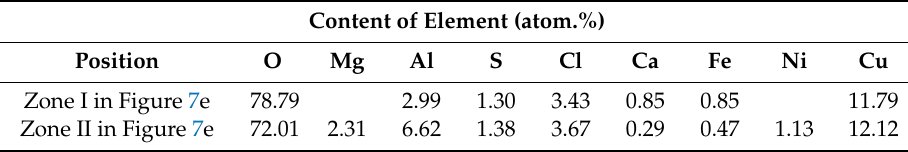
Table 4. The composition of the studied position by SEM with EDS. Content of Element